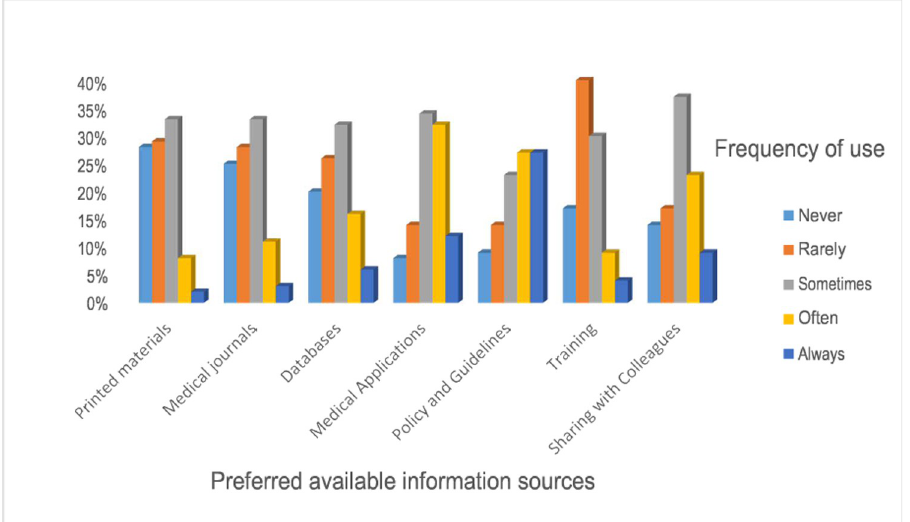
Fig 3. Preferences on sources of evidence-based practice among nurses in University of Gondar and Tibebe Gion teaching specialized hospitals, 2020 (n = 507).